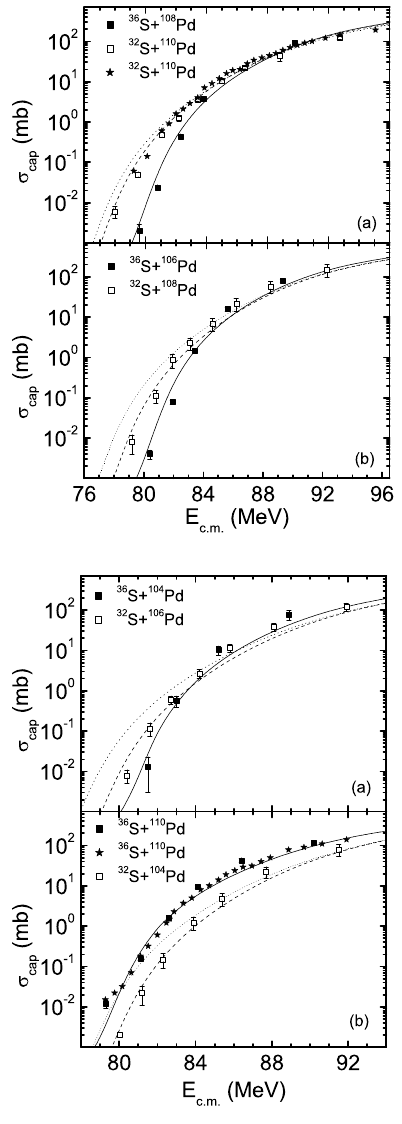
Figure 7. The calculated capture cross sections vs E c . m . for the reactions 32 S + 108 , 110 Pd (dashed lines) and 36 S + 106 , 108 Pd (solid lines) (a,b). For the 32 S + 110 Pd reaction (a), the calculated capture cross section without the neutron transfer process is shown by a dotted line. For the reaction 32 S + 110 Pd, the experimental data from [18] and [19] are marked by open squares and stars, respectively.